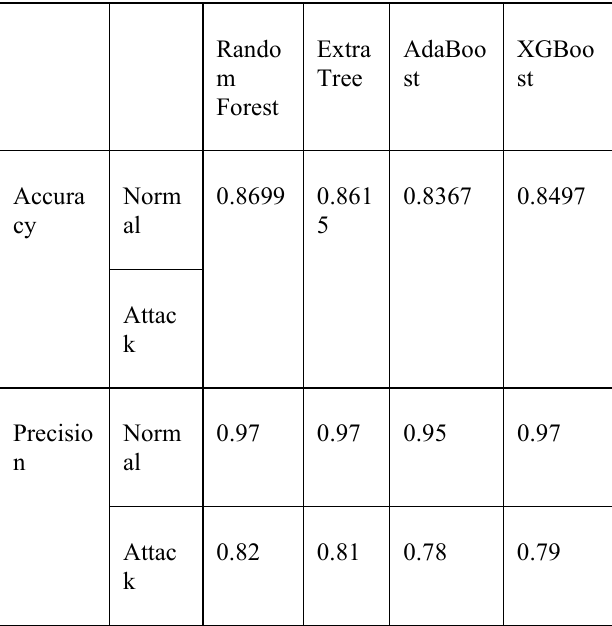
Table 3. List of evaluation parameters for